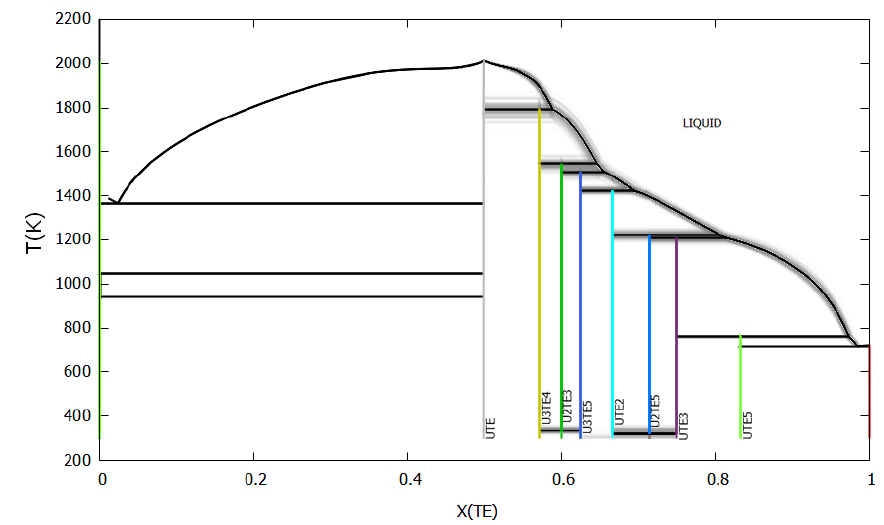
Figure 12. Simulation of N = 100 phase diagram from the parameters posterior probability